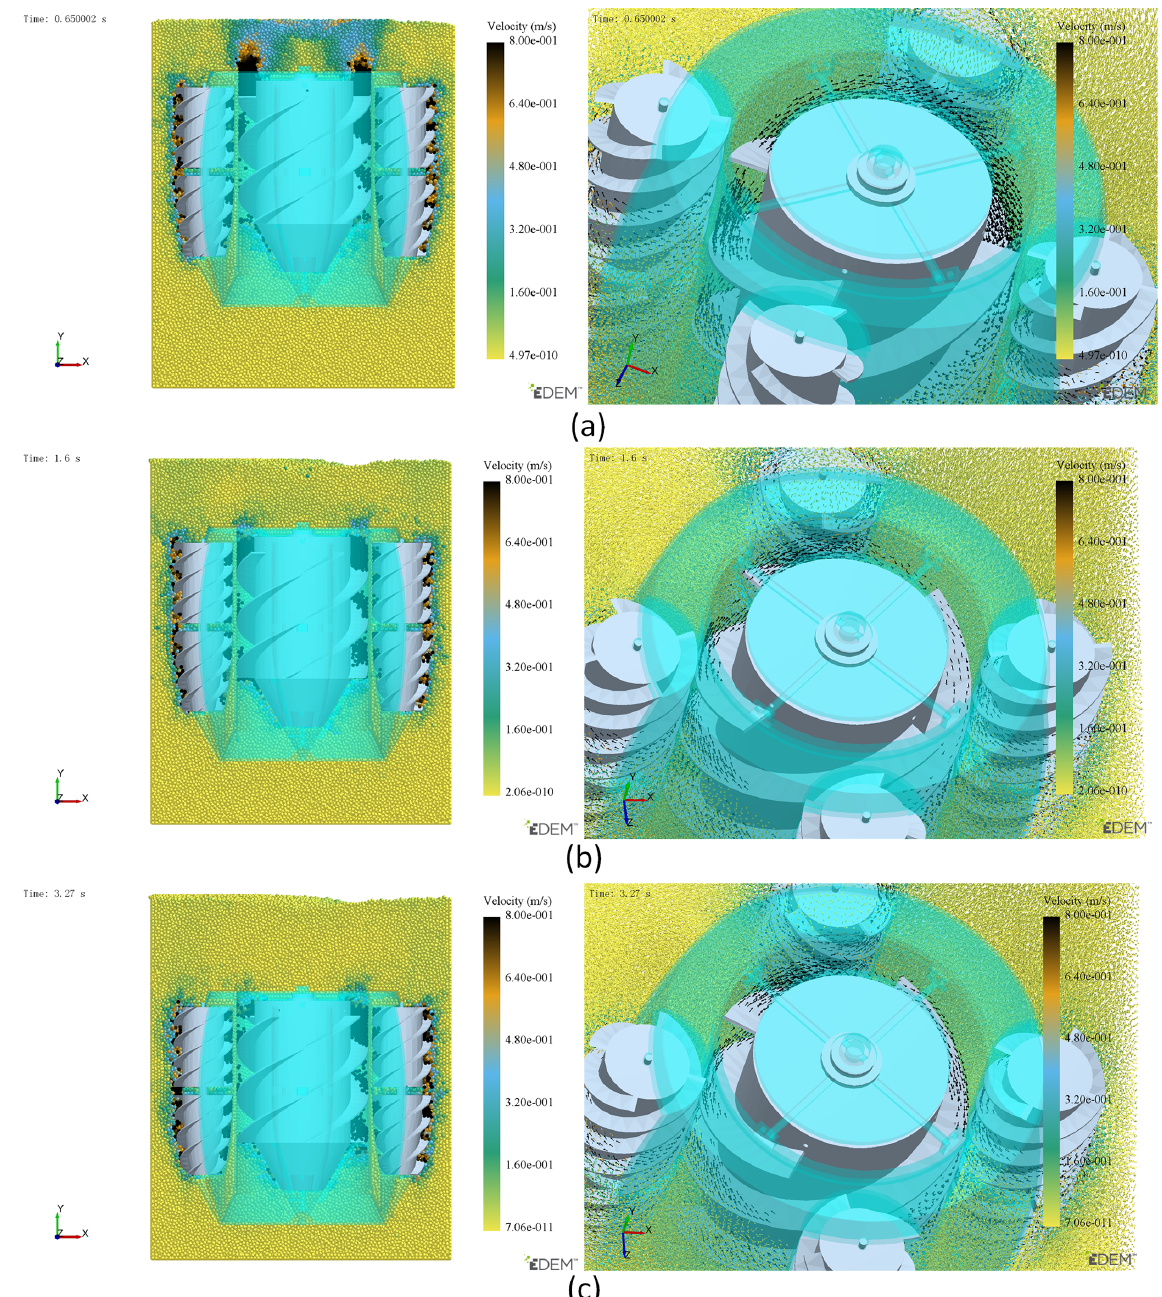
Figure 11. Particle state and particle velocity vector transmitted by the screw transport drum at three moments.